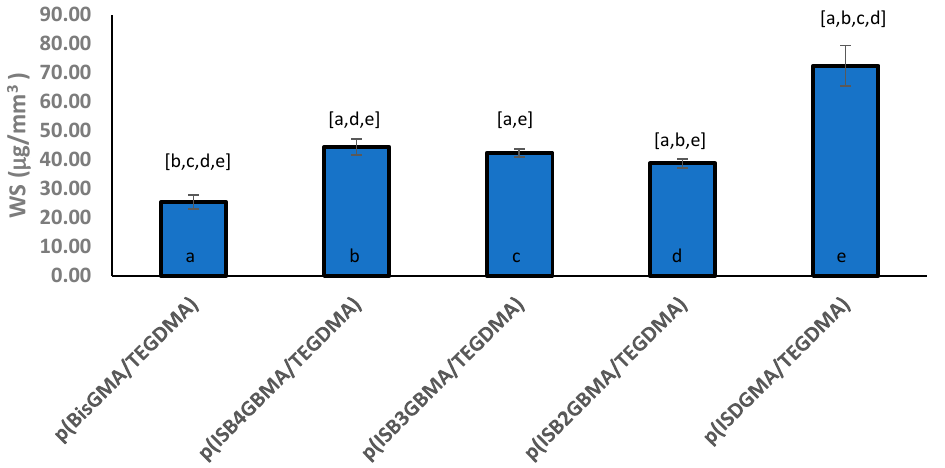
Figure 11. Water sorption of p(BisGMA/TEGDMA), p(ISB4GBMA/TEGDMA), p(ISB3GBMA/TEGDMA), p(ISB2GBMA/TEGDMA), and p(ISDGMA/TEGDMA) at 60:40 wt%. Letters indicate statistically significant difference ( p < 0.05) based on group. Individual groups are represented by (a–e).